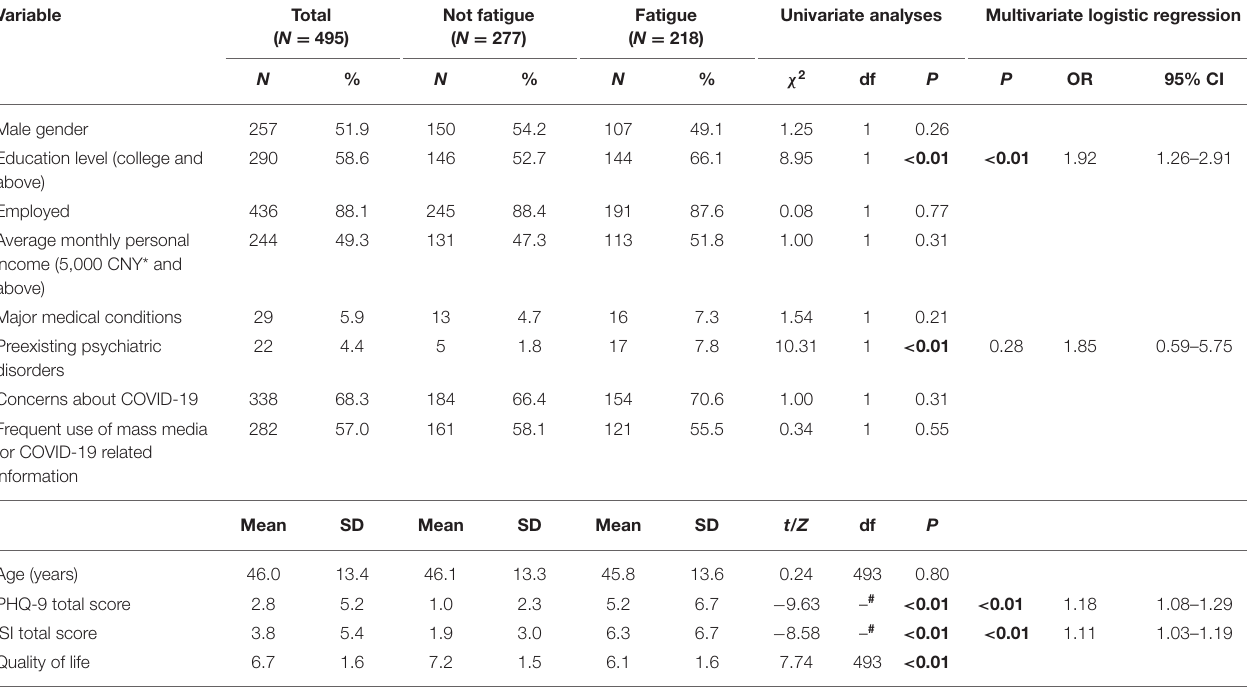
TABLE 1 | The demographic and clinical characteristics of the participants and their association with fatigue. Variable Total